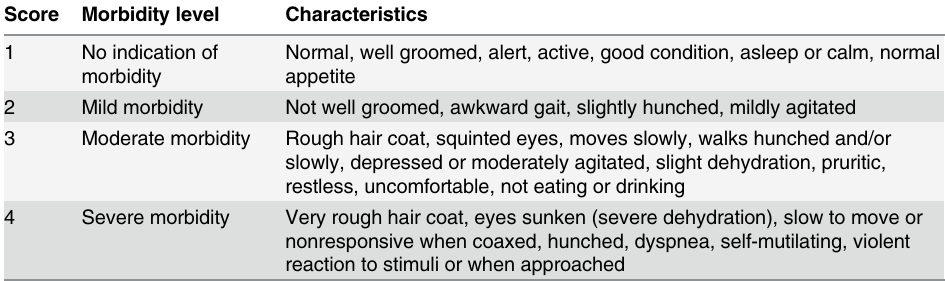
Table 1. Assessing